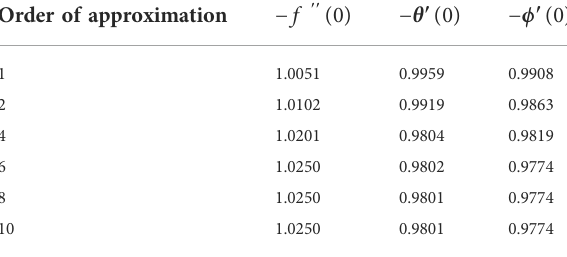
TABLE 3 Convergence of homotopic solutions for fi xed β 1 = N b = N t = Le = M = S = 0.1, β t = β c = 0.5, and Pr = 2.0. Order of